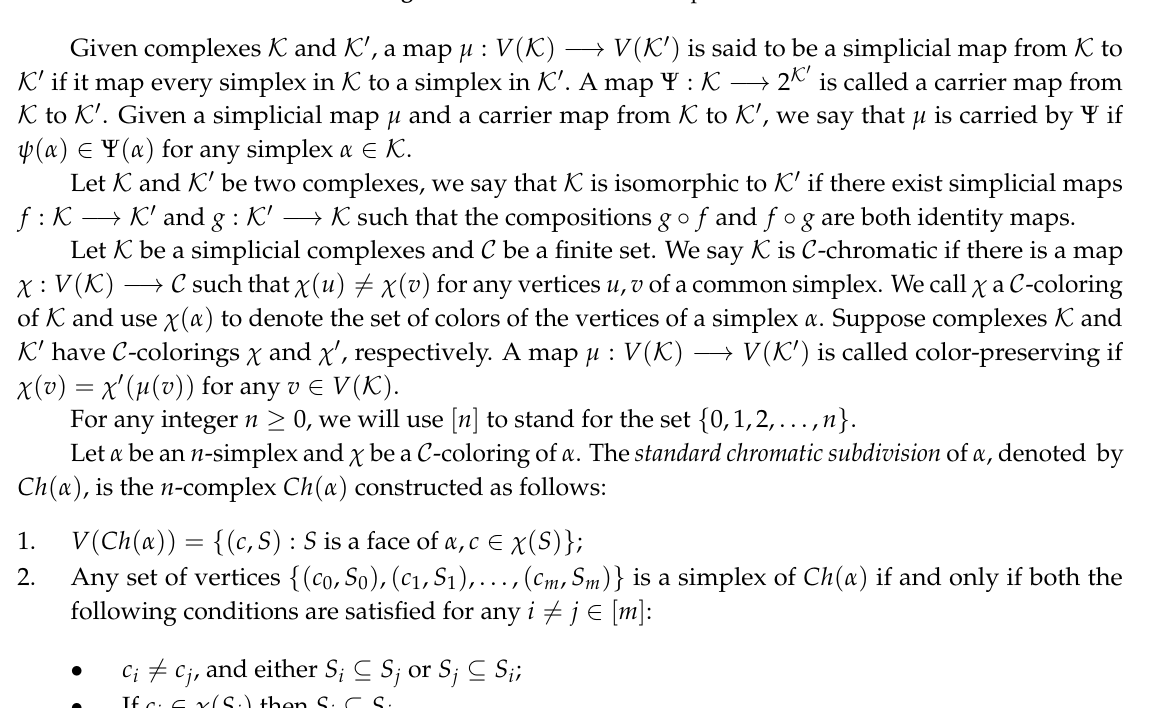
Figure 1. Low dimensional simplexes.